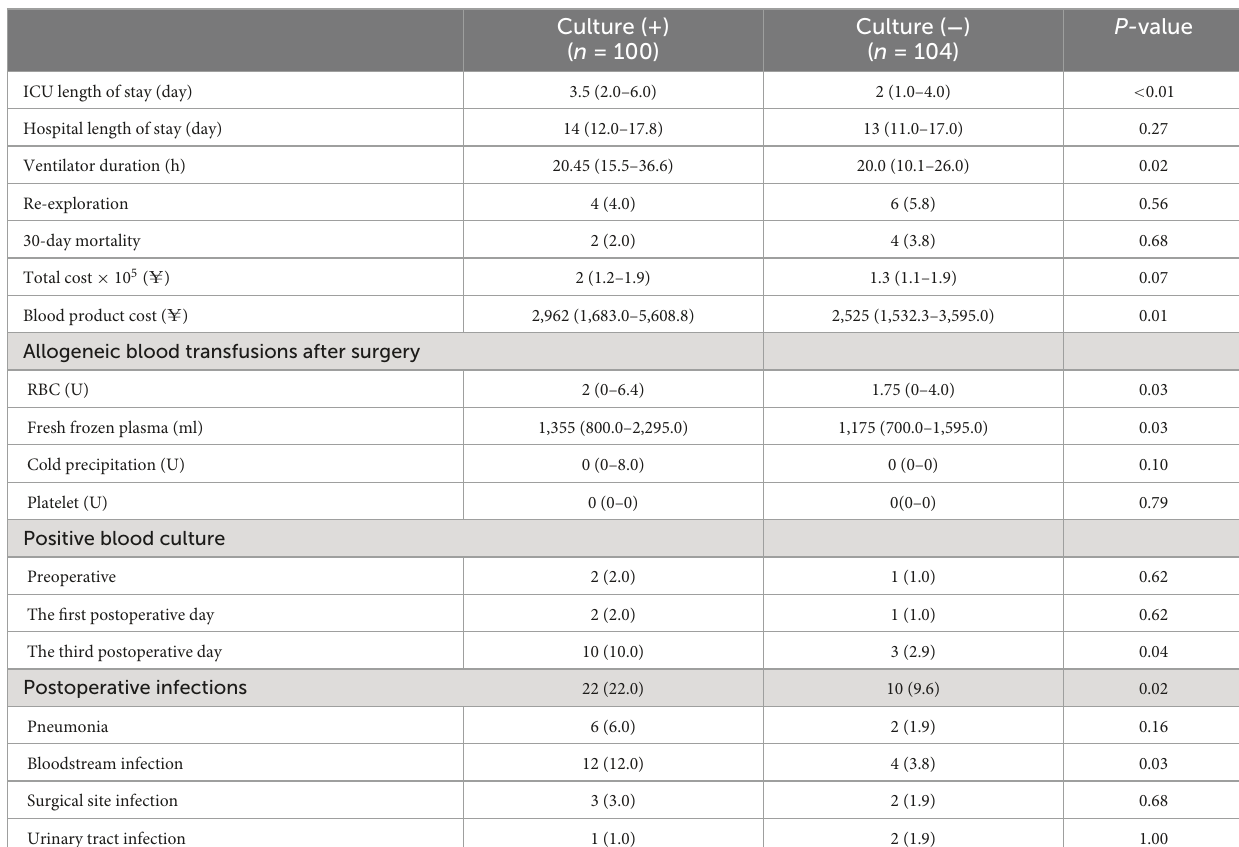
TABLE 4 Postoperative patient outcome data.